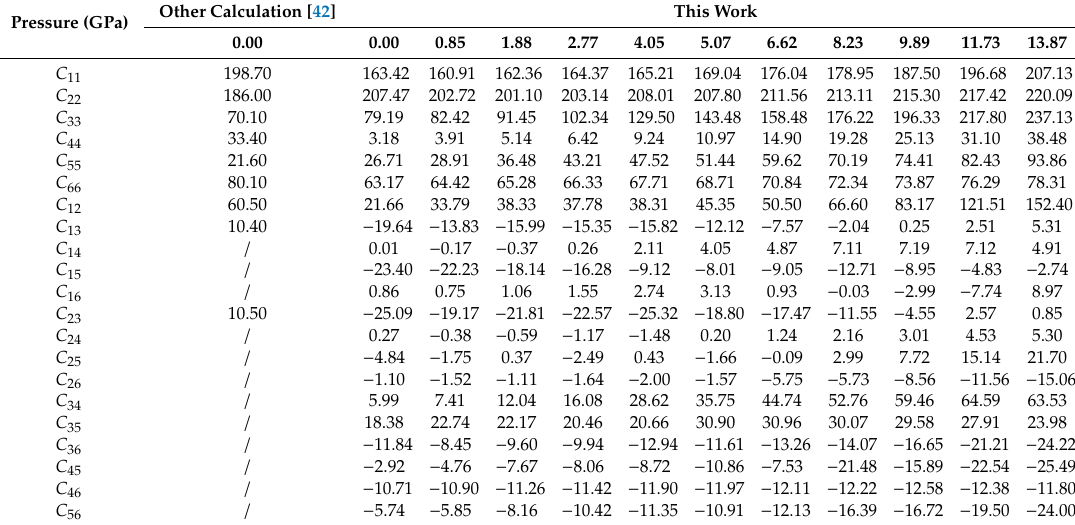
Table 4. The calculated elastic constants C ij (GPa) of pyrophyllite [Al 4 Si 8 O 20 (OH) 4 ] at 0 GPa compared with other calculated results and the calculated values under applied